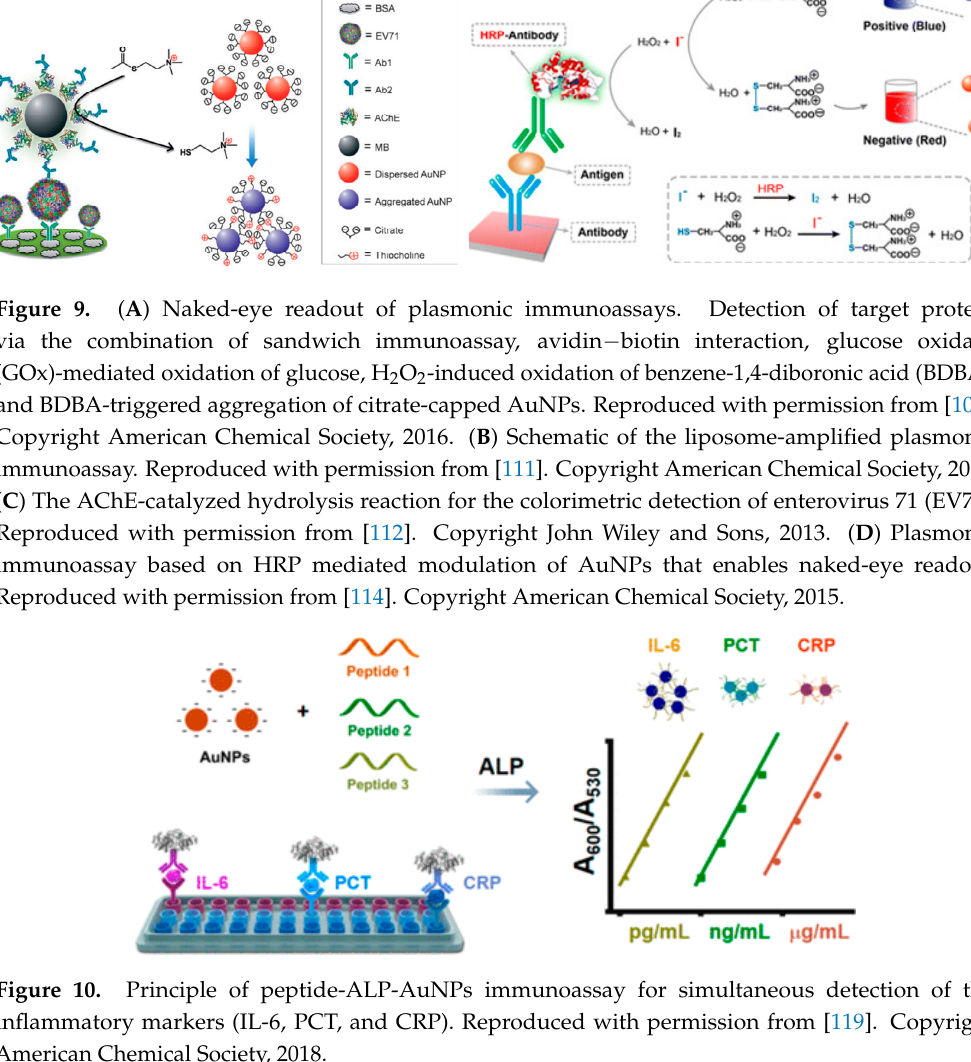
Figure 10. Principle of peptide-ALP-AuNPs immunoassay for simultaneous detection of the inflammatory markers (IL-6, PCT, and CRP). Reproduced with permission from [119]. Copyright American Chemical Society, 2018.